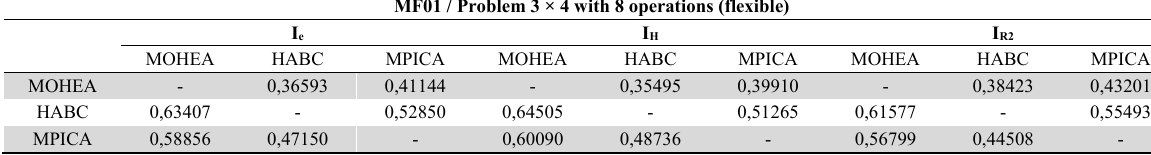
I e , I H , and I R2 (MF02) for HABC, MPICA and MOHEA MF02 / Problem 4 × 5 with 12 operations (flexible) MOHEA